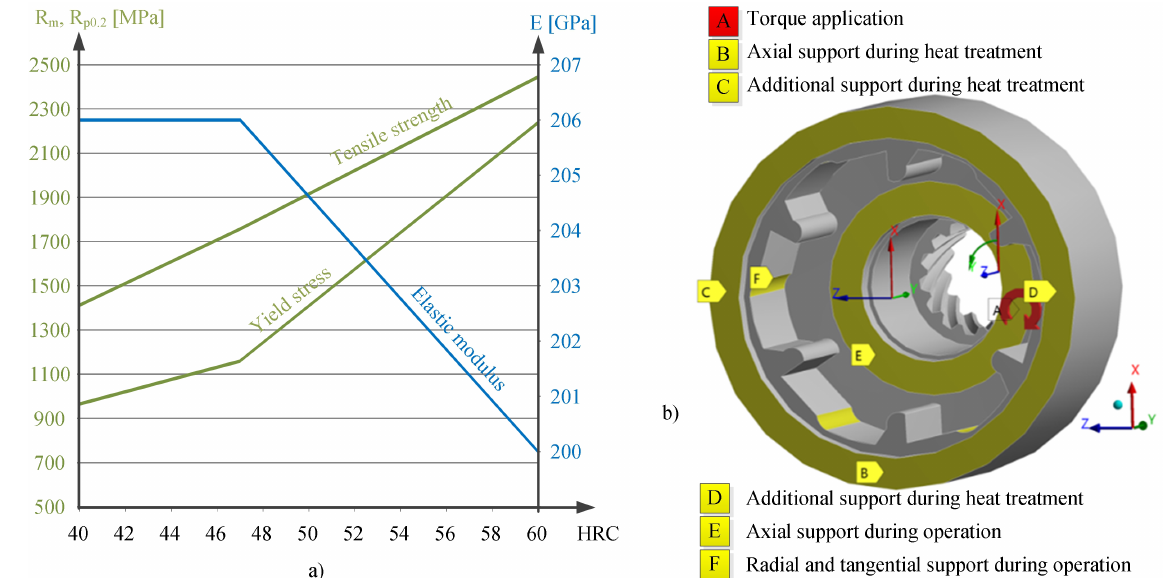
Figure 3. ( a ) Hardness-dependent material properties of AISI/SAE 4142 steel [24]. ( b ) The boundary conditions during the heat treatment process and the typical operation.